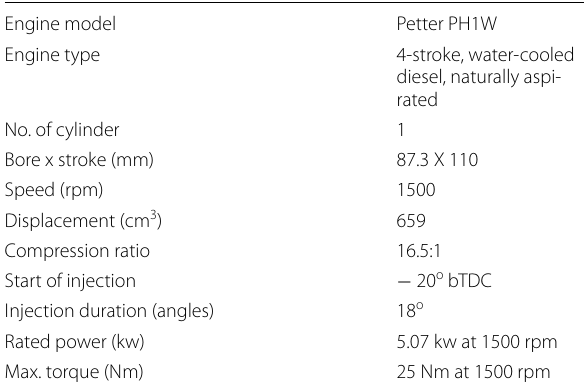
Table 4 Engine specifications Engine model